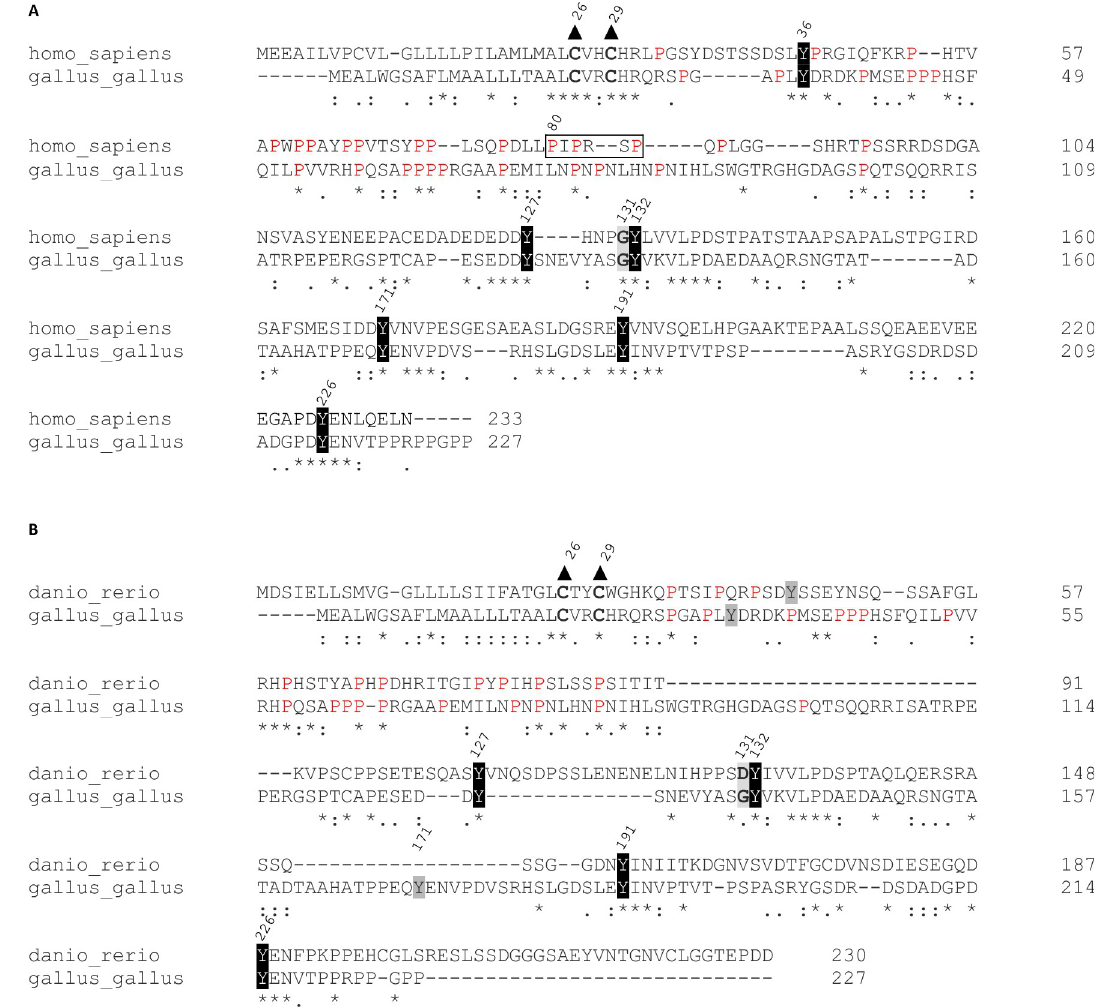
Fig 3. cLAT contains conserved palmitoylation and signaling motifs. The alignments of amino acid LAT sequences of human and chicken (A) and zebrafish and chicken (B) are shown. Conserved tyrosine residues are highlighted in black, glycine and/or aspartate at position 131 is highlighted in grey, conserved palmitoylated cysteines are in bold with black triangle, prolines in the proline-rich sequence (amino acids 30–100 of hLAT) are in red, proline-rich LCK-binding motif is highlighted in the hLAT